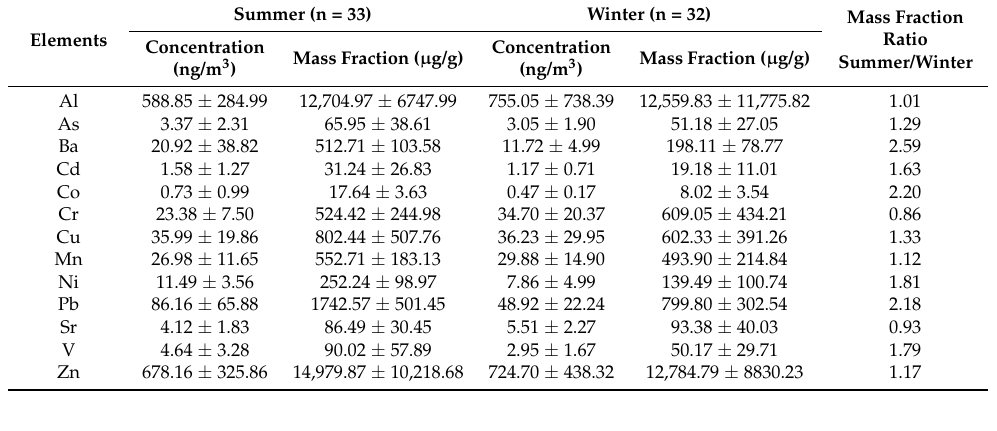
Table 1. Average mass concentrations (ng/m 3 ) and mass fractions ( µ g/g) of heavy metals in PM 2.5 in summer and winter.